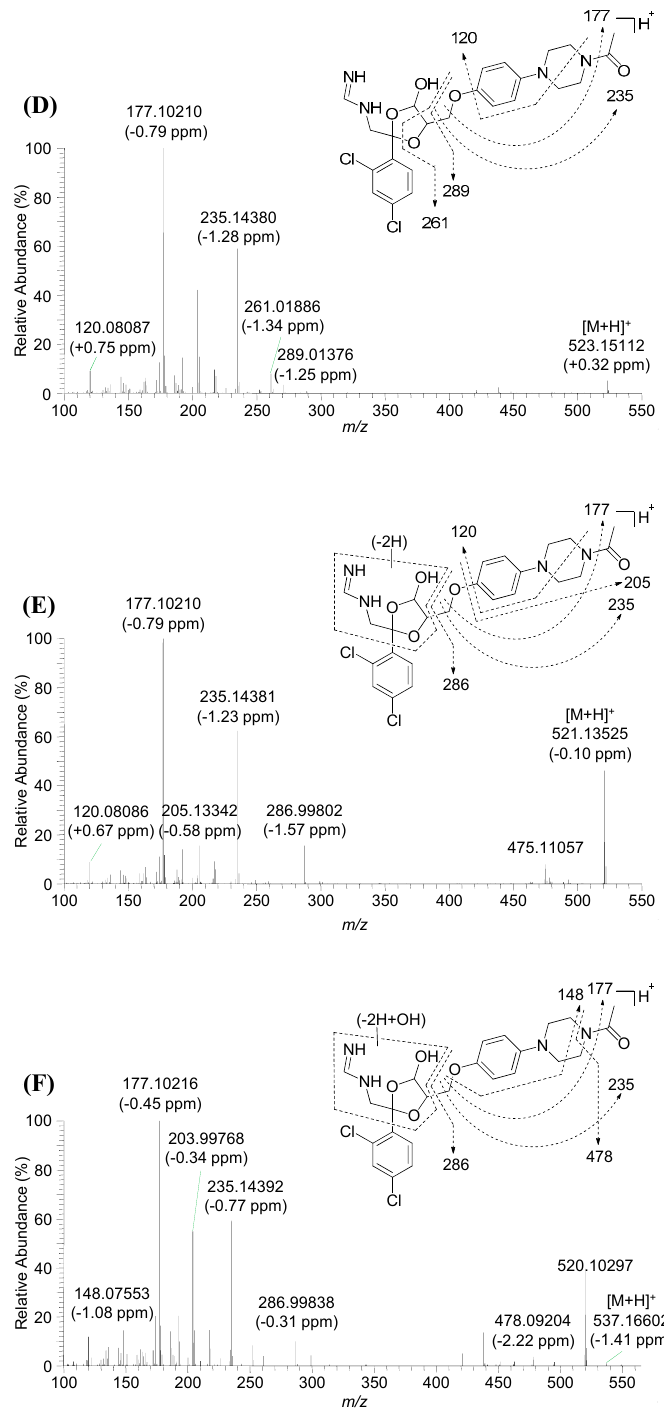
Figure 3. MS/MS spectra and ion chemistries of ketoconazole and newly identified metabolites. ( A ) Ketoconazole; ( B ) M17; ( C ) M20; ( D ) M22; ( E ) M27; and ( F ) M28.